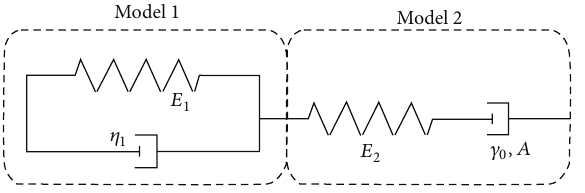
Figure 14: Proposed viscoelastic-viscoplastic model.